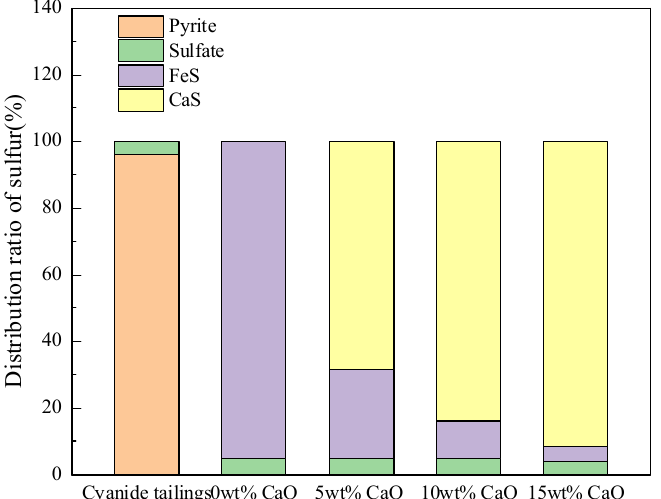
Figure 7. Sulfur phase composition of roasted products under different CaO dosage.